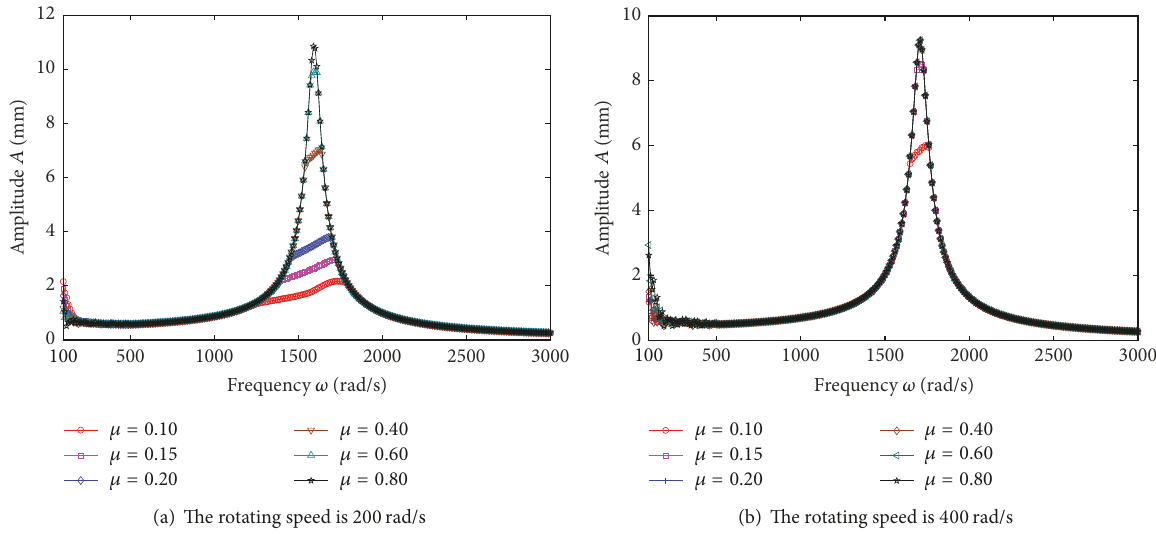
Figure 6: The amplitude-frequency response curves of blade at different friction coefficients.